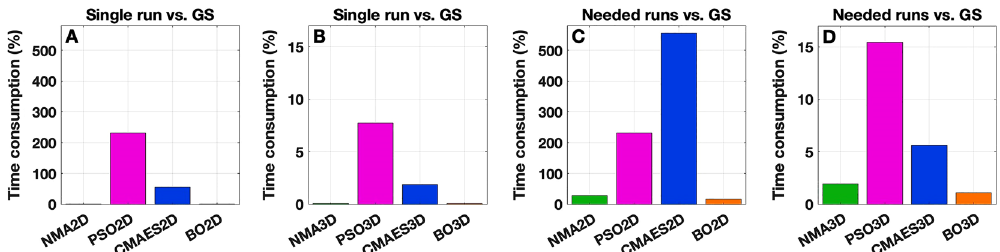
Figure 9. Computation time necessary for the execution of the optimization algorithms in relation to that used for the grid search (GS). ( A , B ) Ratios between the computation time of a single run of the optimization algorithms and the grid search averaged over all algorithm executions and subjects. The individual ratios are ( A ) 2Dim case: NMA2D 1.8%, PSO2D 231.0%, CMAES2D 55.6% and BO2D 1.9%; ( B ) 3Dim case: NMA3D 0.1%, PSO3D 7.7%, CMAES3D 1.9% and BO3D 0.1%. ( C , D ) Relative computation time necessary for reaching 80% of the success probability (see Fig. 8) compared to the time invested for the grid search. The values are obtained by multiplying those from the plots A and B by the respective numbers of needed runs provided in Fig. 8. For NMA3D, where a success probability of 80% could not be reached, 24 runs are considered necessary. The algorithms are indicated on the horizontal axes along with the percental values of time consumption on the vertical axes for the 2Dim ( A , C) and 3Dim ( B , D ) cases. The figure was created with MATLAB R2018a (www. mathw orks.